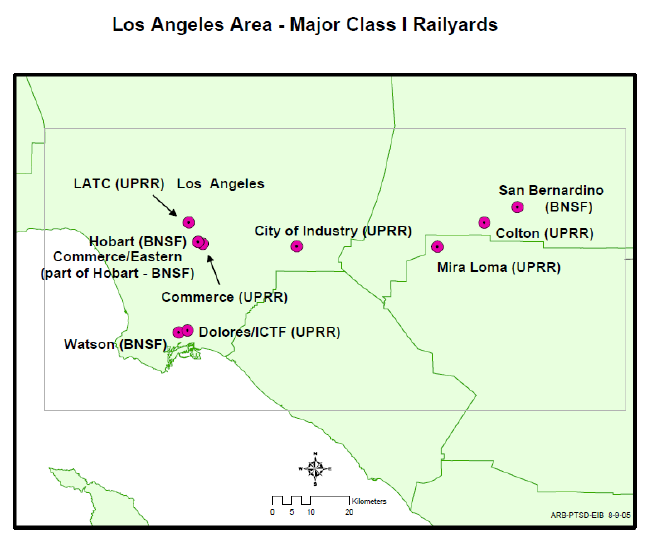
Figure 3. Map* showing locations of the rail yards in the Los Angeles area of California for which CARB conducted